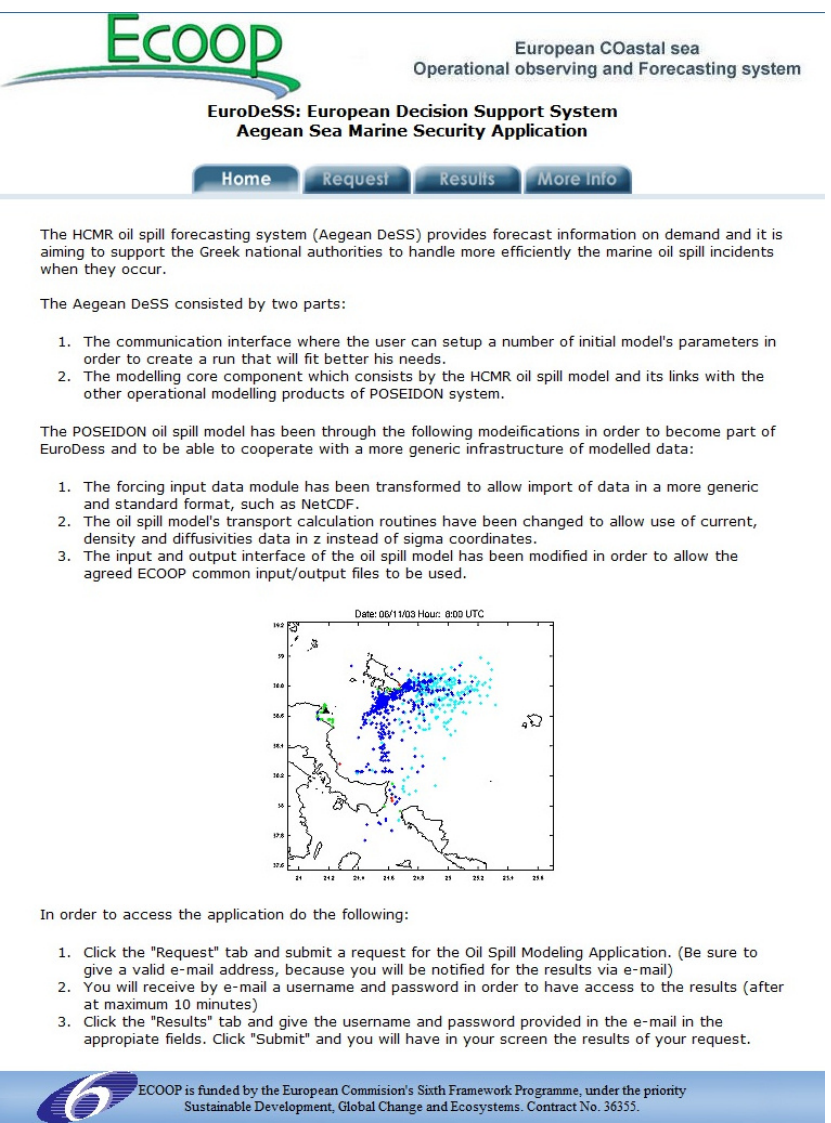
Figure 2: The introductory page of the Aegean DeSS provides general information about the system’s use.